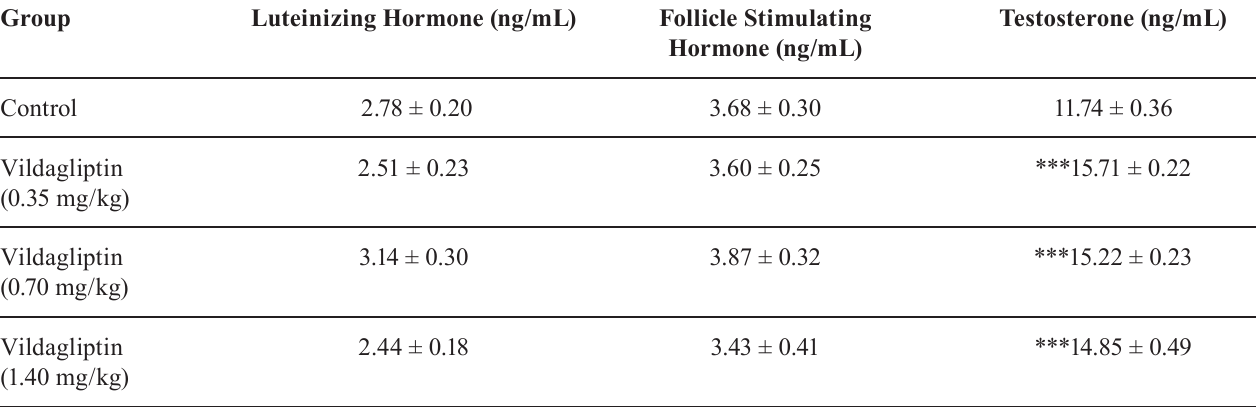
TABLE IV – Effect of vildagliptin on reproductive hormones of Wistar rats (Recovery)